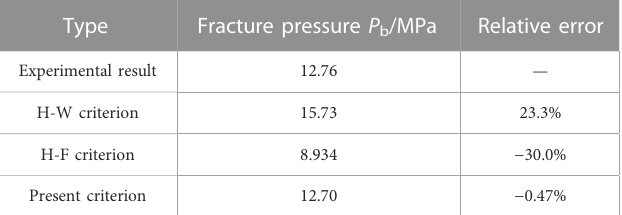
TABLE 3 Comparison of fracture pressure when the pore pressure is